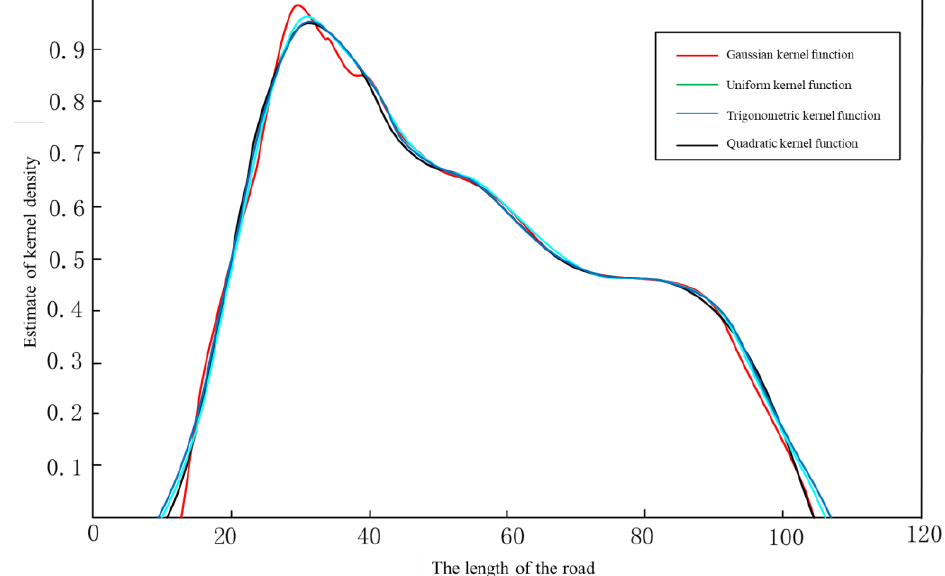
Figure 3. Fitting curves of kernel density estimation for different kernel functions.